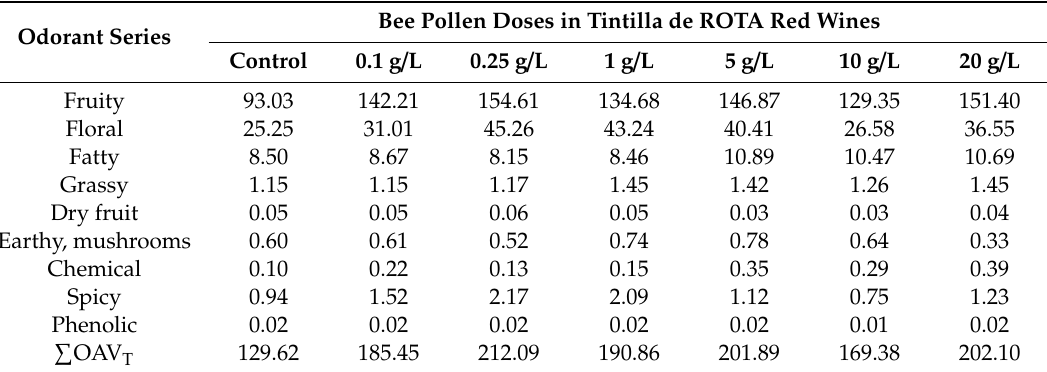
Table 3. Odor activity values summary ( Σ OAV) grouped by odorant